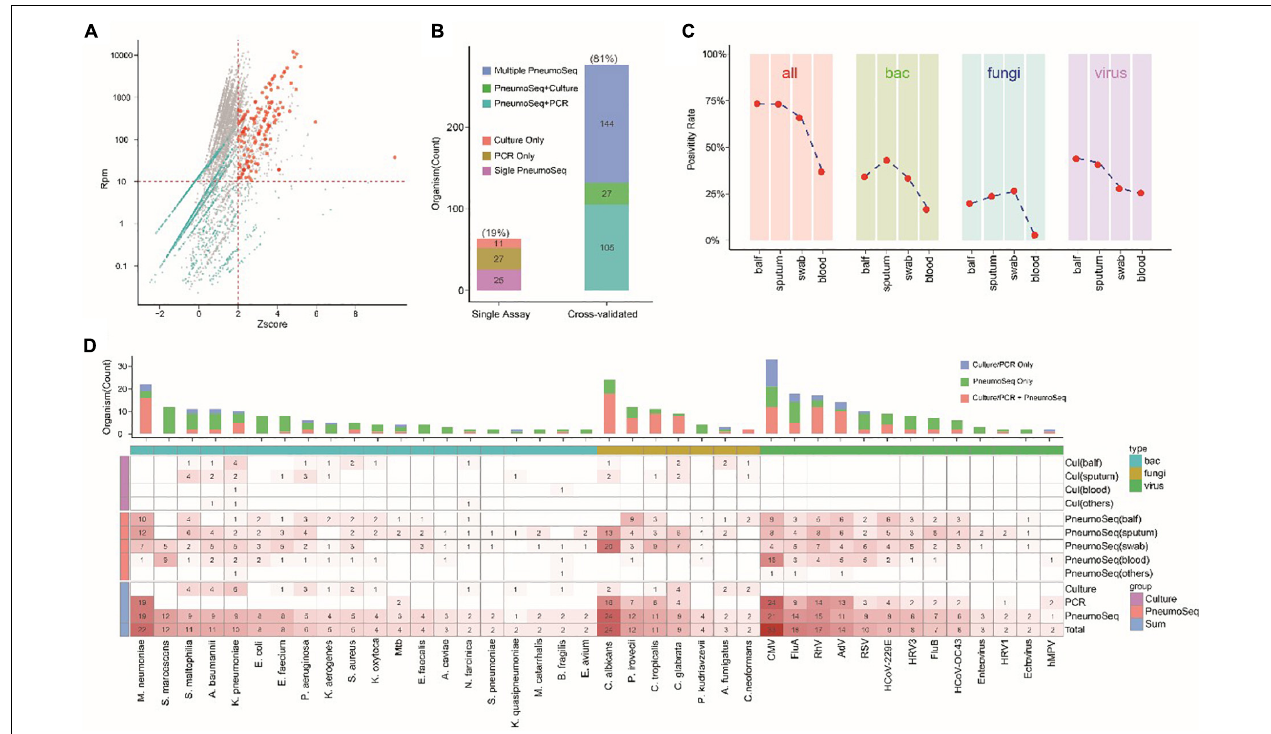
FIGURE 2 | Development and validation of PneumoSeq. (A) Representative plot showing the identification of outlier organisms. Red, potentially pathogenic microbes that were considered outliers in terms of both abundance and read numbers. Green, all other potentially pathogenic microbes; gray, kitome contaminants that were considered background and were removed. (B) Cross-validation of testing results. Multiple PneumoSeq, organisms detected in multiple samples by PneumoSeq; PneumoSeq + culture and PneumoSeq + PCR, organisms detected by both PneumoSeq and culture or by both PneumoSeq and PCR, respectively. (C) Positivity rates of PneumoSeq results in different types of specimens. (D) Potential pathogens detected in our study. Bar graphs show cumulative results. Heatmap shows methods applied to various sample types. Only those microorganisms detected 2 or more times were included. * P < 0.05 by Fisher’s exact test. bac, bacteria; cul, culture; BALF, bronchoalveolar lavage fluid; PCR, polymerase chain reaction; Mtb, Mycobacterium tuberculosis; CMV, cytomegalovirus; FluA, influenza virus type A; FluB, influenza virus type B; RhV, rhinovirus; AdV, adenovirus; RSV, respiratory syncytial virus; HRV3, human respiratory virus type 3; HCoV, human coronavirus OC43; hMPV, human